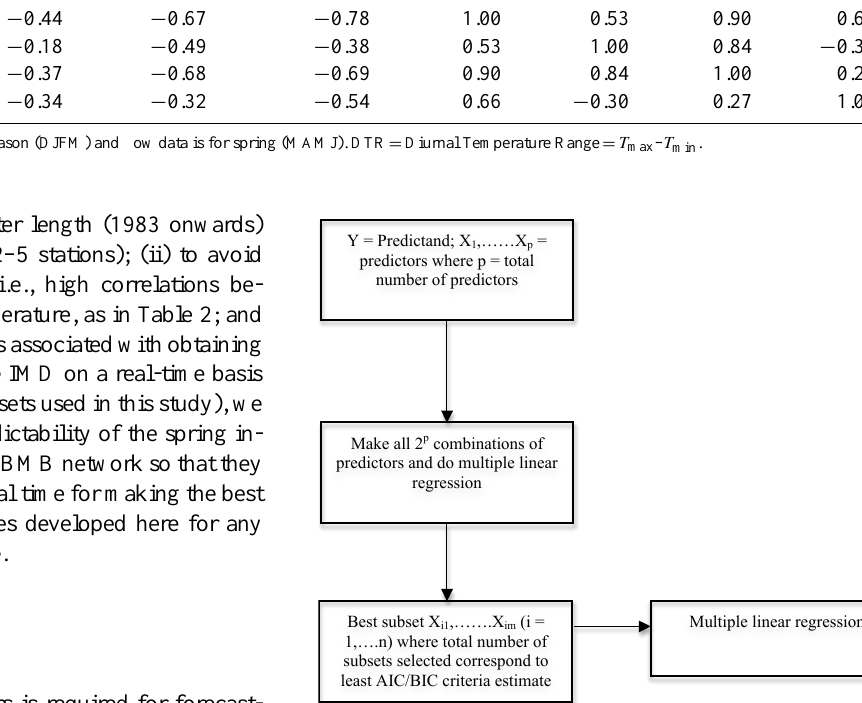
Fig. 4. Flowchart showing the bestglm Fig 4: Flowchart showing the bestglm method.